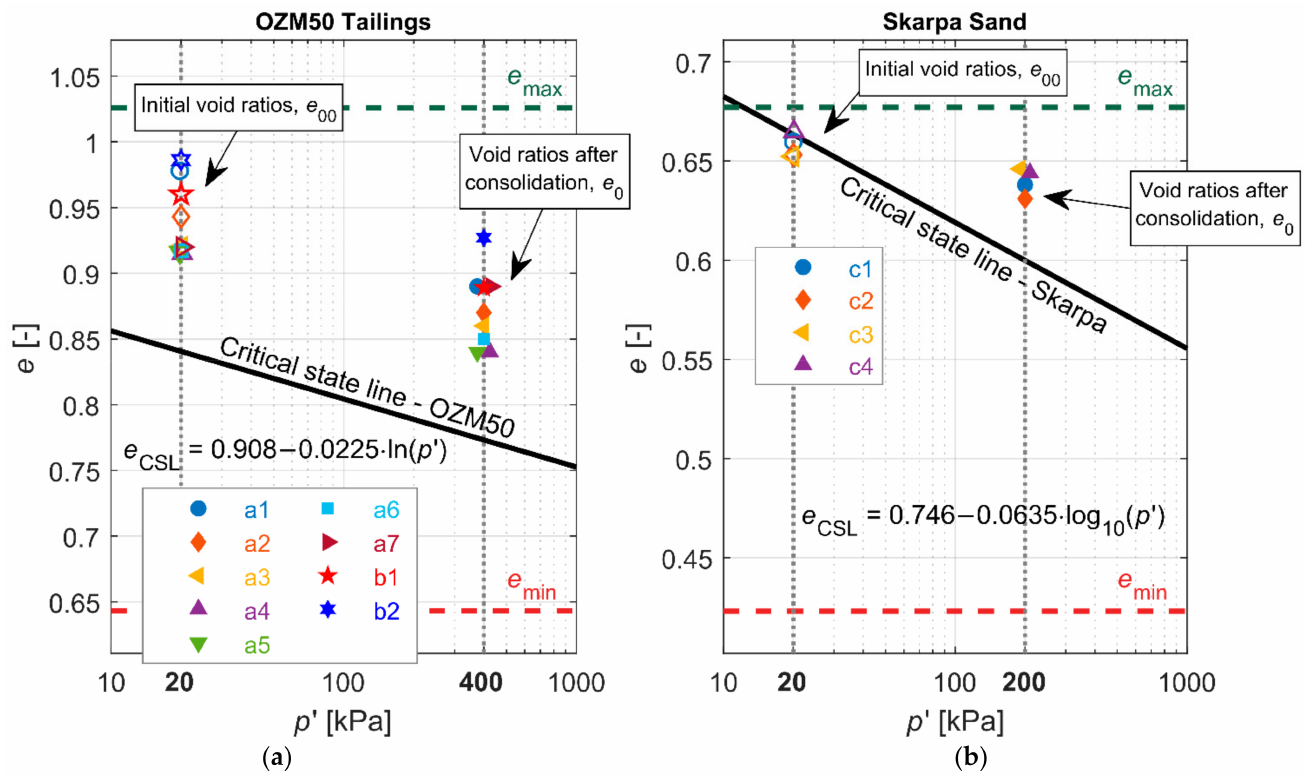
Figure 8. Initial states of soil samples before